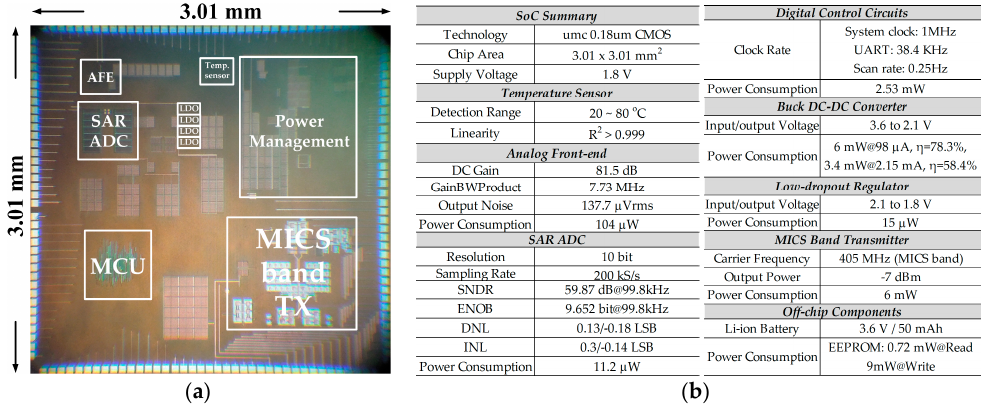
Figure 16. ( a ) The micrograph of the proposed SoC; ( b ) Measured performance summary.